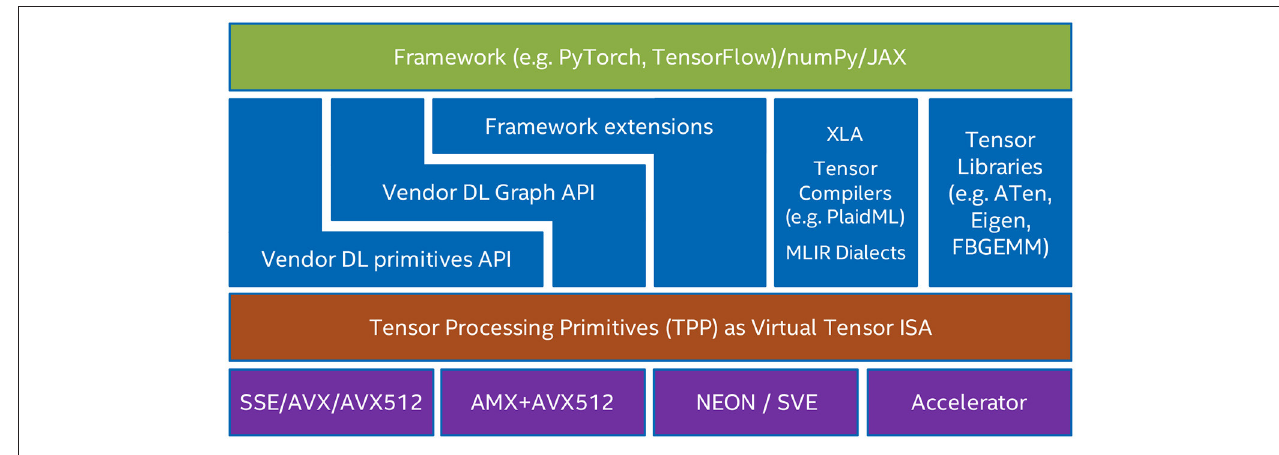
FIGURE 1 | Use-cases of TPPs in various software